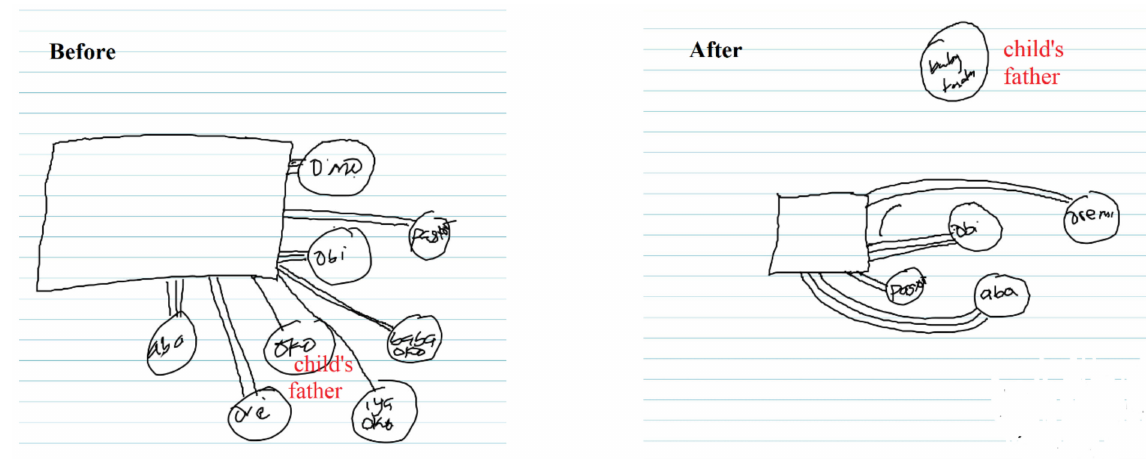
Figure 2. Owo epo ni araye n’banila, won ki n’banila t’eje [people will help you lick your fingers if drenched in palm oil, but not when it is drenched in blood] (SK12).